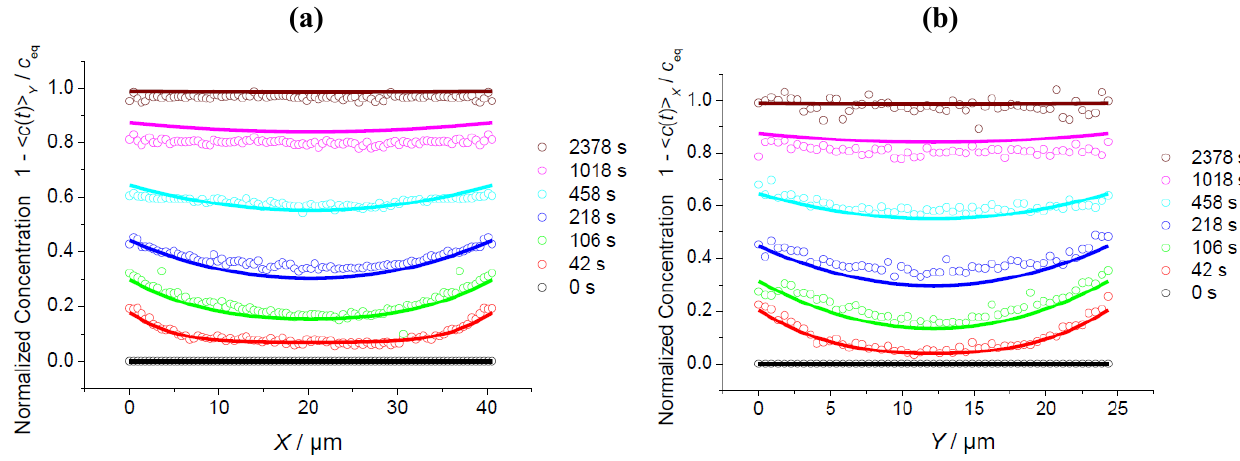
Figure 6. Profiles of mean concentrations during release of 4-methyl-2-pentyne observed perpendicular to the XZ plane along X ( a , see Figure 1b, Scheme 1, central line) and perpendicular to the YZ plane along Y ( b , Figure 1b, Scheme 2) and comparison with the solution of Fick’s 2nd law with the diffusivities and surface permeabilities given in Table 1 (solid lines).